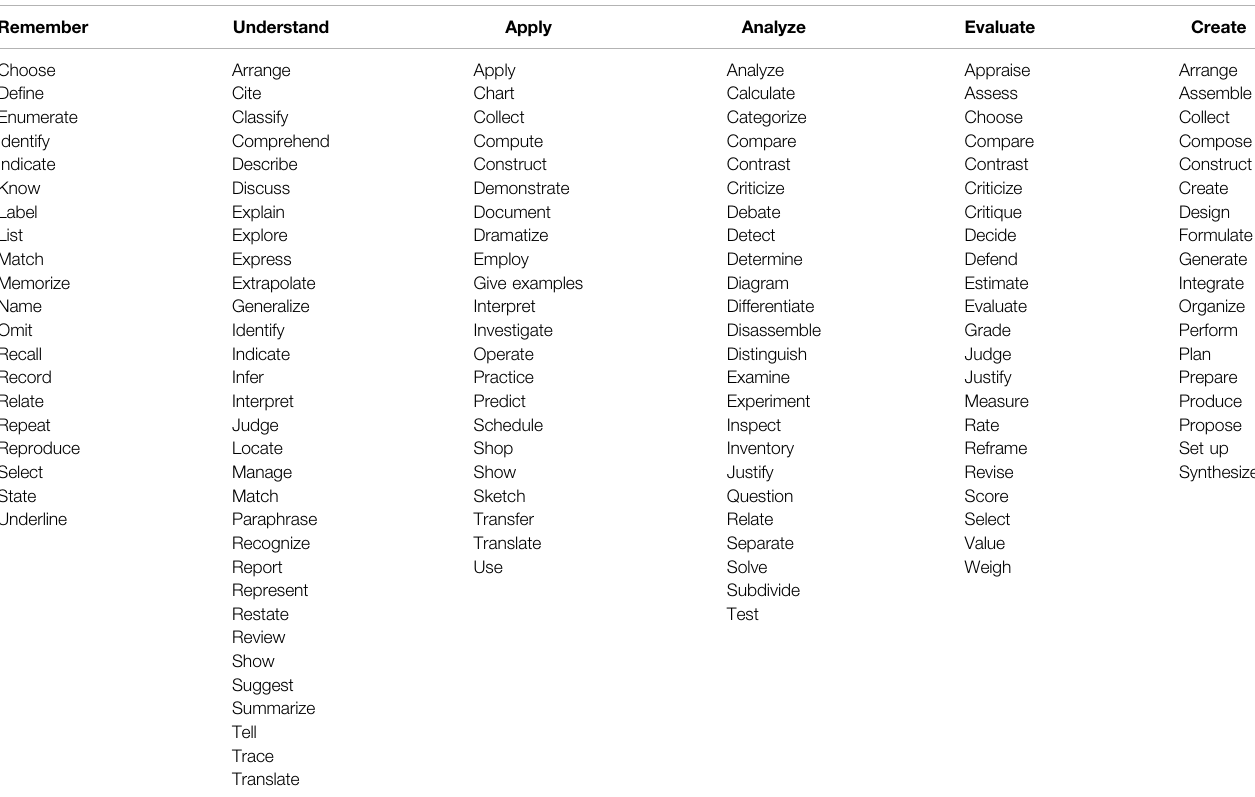
TABLE 1 | Bloom ’ s Taxonomy categories and associated verbs (Anderson and Krathwohl